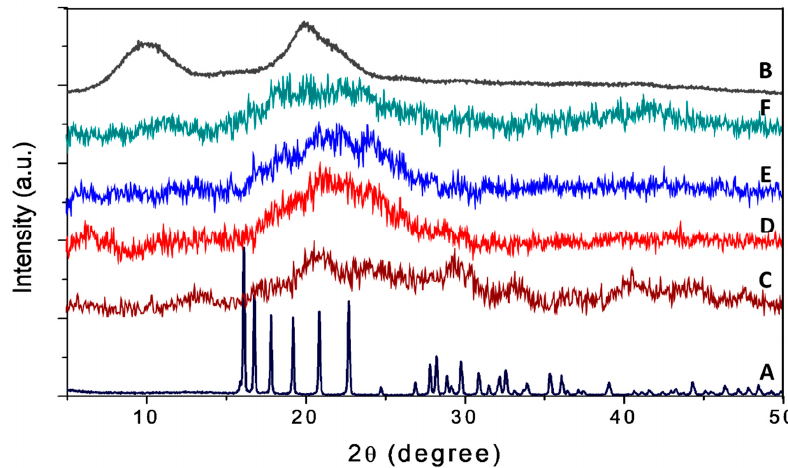
Figure 1. Powder XRD patterns of ( A ) pure dazomet, ( B ) chitosan, and chitosan-dazomet nanoparticles prepared at various concentrations of tripolyphosphate (TPP): ( C ) 2.5, ( D ) 5, ( E ) 10, and ( F ) 20 mg /